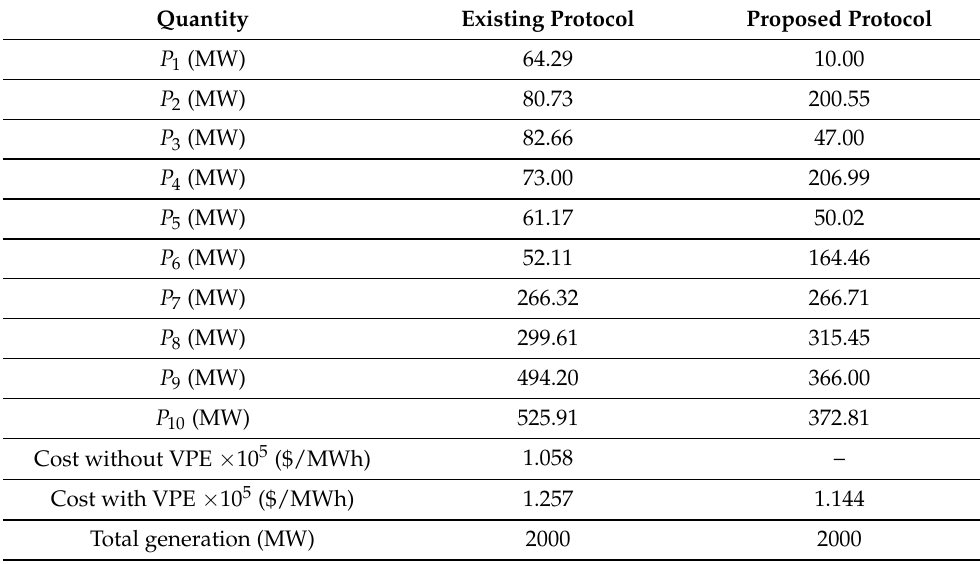
Table 5. Comparison with distributed approach.